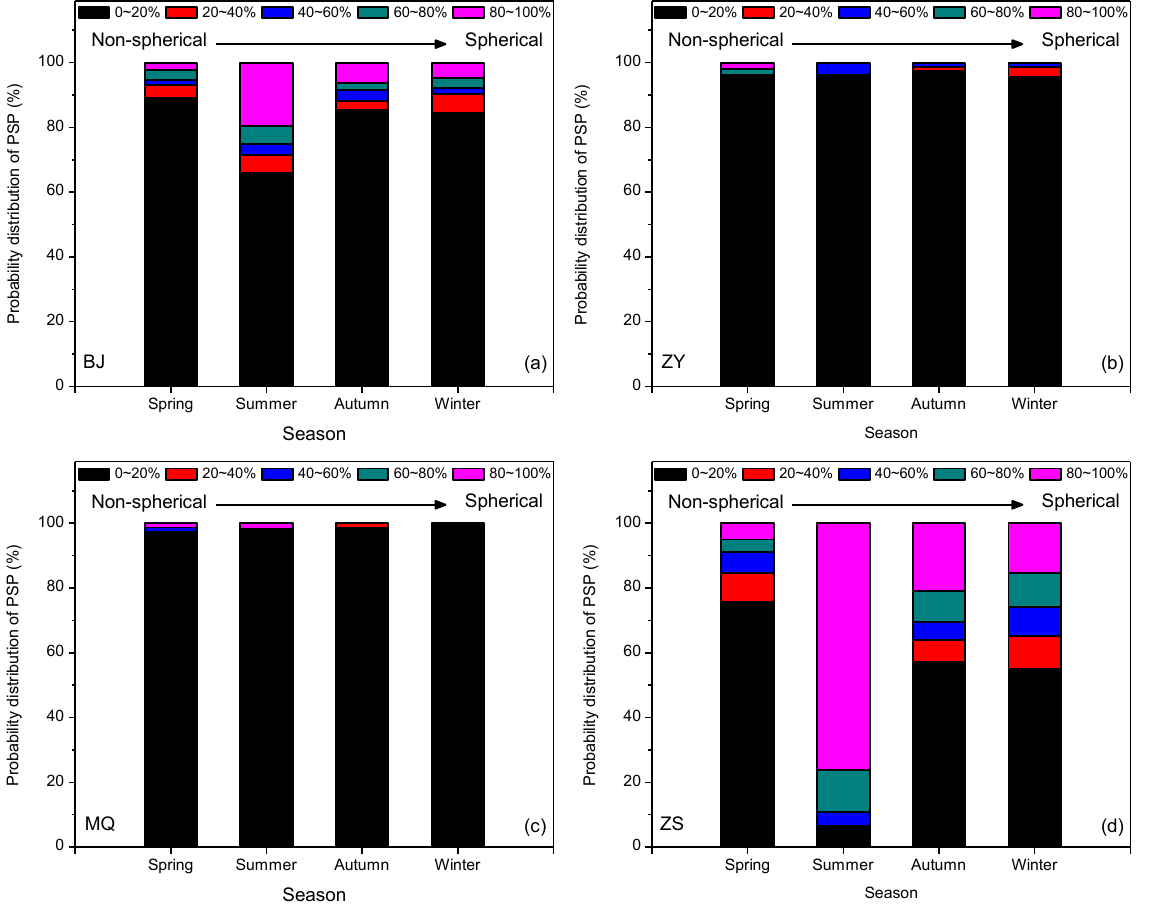
Figure 8. The probability distribution of the percentage of spherical particles (PSP) of the four sites, ( a ) Beijing site; ( b ) Zhangye site; ( c ) Minqin site; ( d ) Zhoushan site. The different colors indicate the probabilities of PSP lying within each of the five